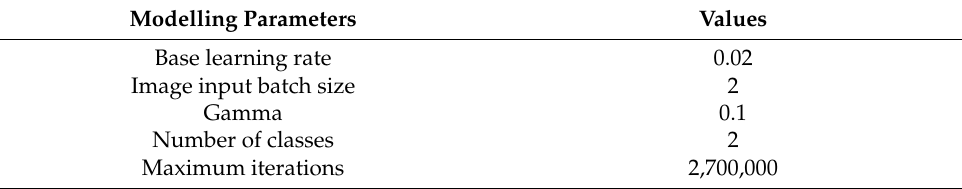
Table 1. Modeling parameter settings.